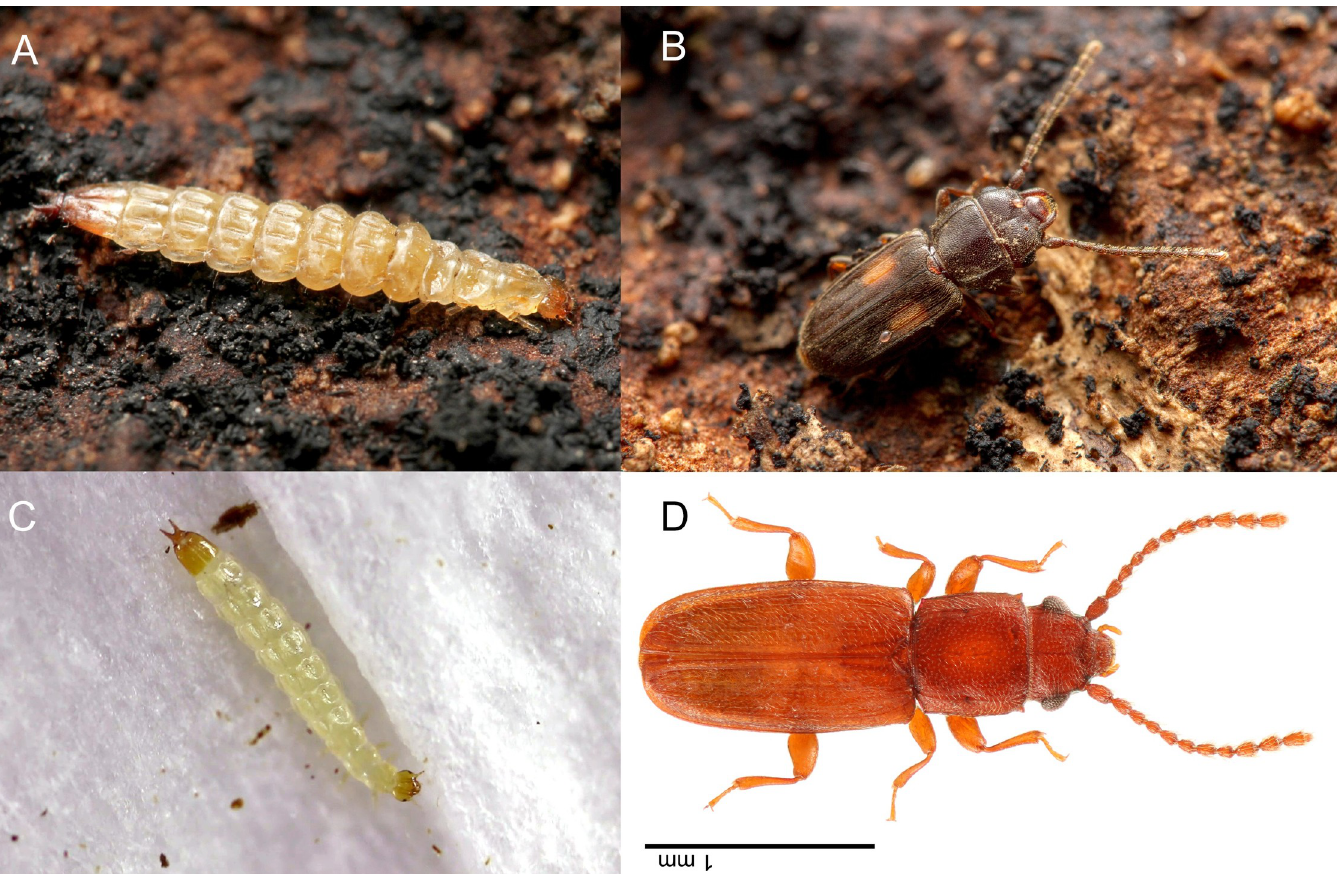
Fig 2. Laemophloeus biguttatus jump sequences (A-C and D are separate jumps) taken from videos filmed at 3,200 frames per second. A-C: loading, latch- decoupling, and launch phases of a jump, timecode labels on images correspond to the image of the beetle they are nearest; D: complete jump trajectory. A: loading phase, during which the body slowly bends ventrally. 0.119 seconds elapse between top and bottom body postures. Bottom image is the frame directly preceding the top larval image in B. B: latch-decoupling sequence, during which the legs release or lose their grip on the substrate. In the pictured jump sequence, the hind and midlegs are first to release their grip, followed by the forelegs. Each larval image is a single sequential frame and only 0.625 ms separate the top and bottom image. C: launch phase, corresponding to the transfer of stored energy to the kinetic energy of the body moving into the air. Shown here are the last frames of the launch phase depicting the last frame in which the larvae has any contact with the substrate (below) and a frame from the airborne phase (above). 5.31 ms separate the bottom image from the top. The bottom image in panel C is 1.8 ms after the bottom image in panel B. D: Airborne phase of a separate jump from that depicted in panels A-C. The entire sequence spans 0.081 seconds, noted times pertain to the first, top, and last of the sequential images, and the scale bar pertains only to this panel.